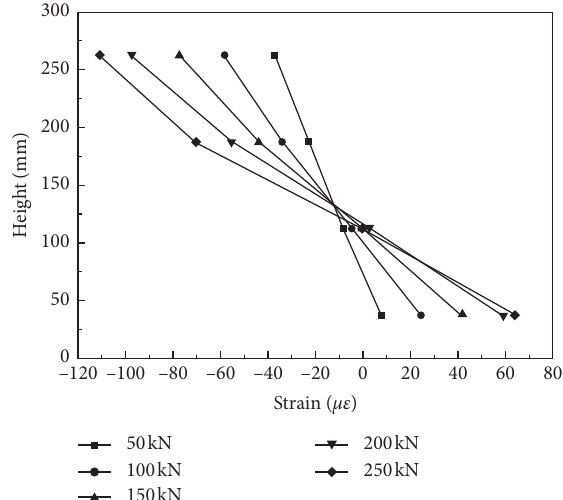
Figure 14: Section height-strain curve.